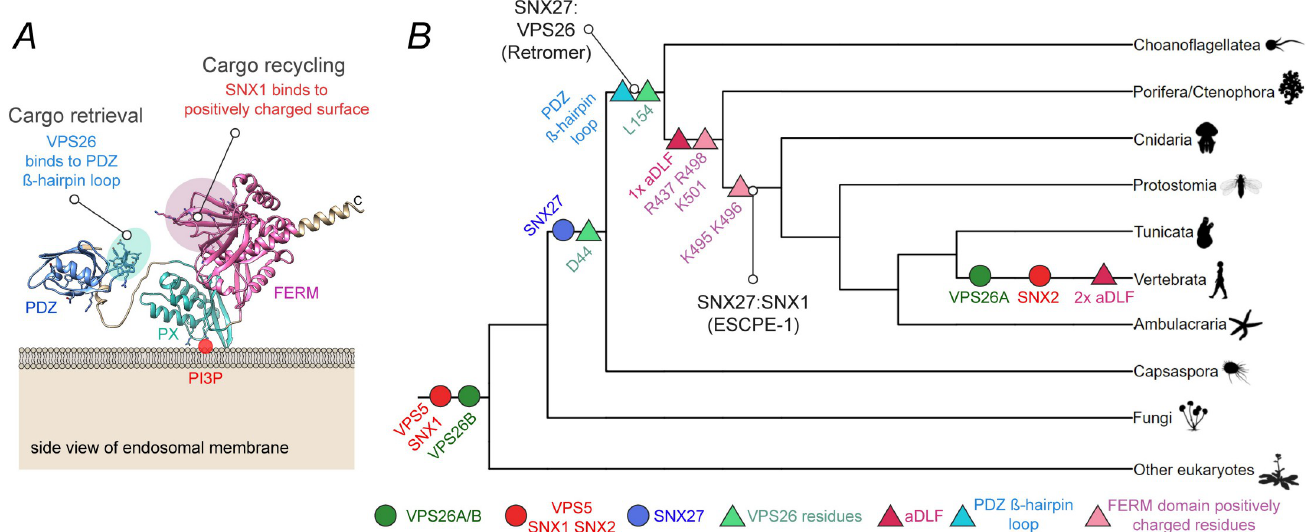
Fig 7. Molecular evolution of the SNX27–Retromer and SNX27-ESCPE-1 interactions. (A) Alphafold2 structural prediction for FL human SNX27 [44]. The residues of the exposed ß-hairpin loop in the SNX27 PDZ domain (67 to 79) that account for the interaction with Retromer are highlighted in cyan. Those residues of the FERM domain that account for the interaction with ESCPE-1 (positively charged surface) are highlighted in pink. Our data support a model where the interaction between SNX27 and Retromer is required for the retrieval of PDZ cargos away from the degradative fate. Subsequently, the interaction between SNX27 and ESCPE-1 is required for the export and endosome-to-plasma membrane recycling of PDZ cargos. (B) A cartoon representation incorporating the results of multiple phylogenetic analyses, including VPS5/SNX1/SNX2, SNX27, and VPS26A/VPS26B (see S4A–S4C Fig for detailed phylogenies). The gene families that contain VPS5/SNX1/SNX2 and VPS26A/VPS26B are present across eukaryotes: SNX1 and SNX2 and VPS26A and VPS26B, arose by gene duplication in the common ancestor of vertebrates. SNX27 is found in metazoans, choanoflagellates and the filasterean Capsaspora , but not in more distantly related opisthokonts such as Ichthyosporea or fungi; it is therefore likely arose in the filazoan common ancestor. The residue D44 (VPS26B, Homo sapiens ) in VPS26 is found across Filazoa, laying the foundations for the binding interaction between VPS26 and SNX27. L154 (VPS26B, H . sapiens ) likely arose in the ancestral choanozoan along with the PDZ loop and key interacting residues (67 to 97 L67, L74, SNX27, H . sapiens ), suggesting that the SNX27–Retromer interaction was already present in the common ancestor of metazoans and choanoflagellates. Key residues of the FERM domain: R437, R498, and K501 (SNX27, H . sapiens ) are recognizable in the ancestral metazoan. The first aDLF motif (SNX1) was acquired in the common ancestor of cnidarians and bilaterians, along with the residues K495 and K496, which make up part of the FERM domain in SNX27, potentially suggesting that SNX27:ESCPE-1 binding has evolved by this time, if not earlier during metazoan evolution. Interestingly, the first aDLF motif does not appear to be present in the placazoan or ctenophoran sequences, (although the R437, R498, and K501 residues are present), which might reflect secondary loss of the motif in these groups. The second aDLF motif is only present in vertebrates.